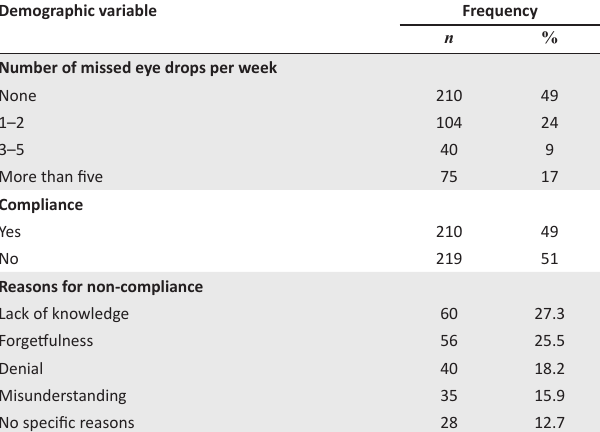
TABLE 3: Practice regarding level of compliance ( n =